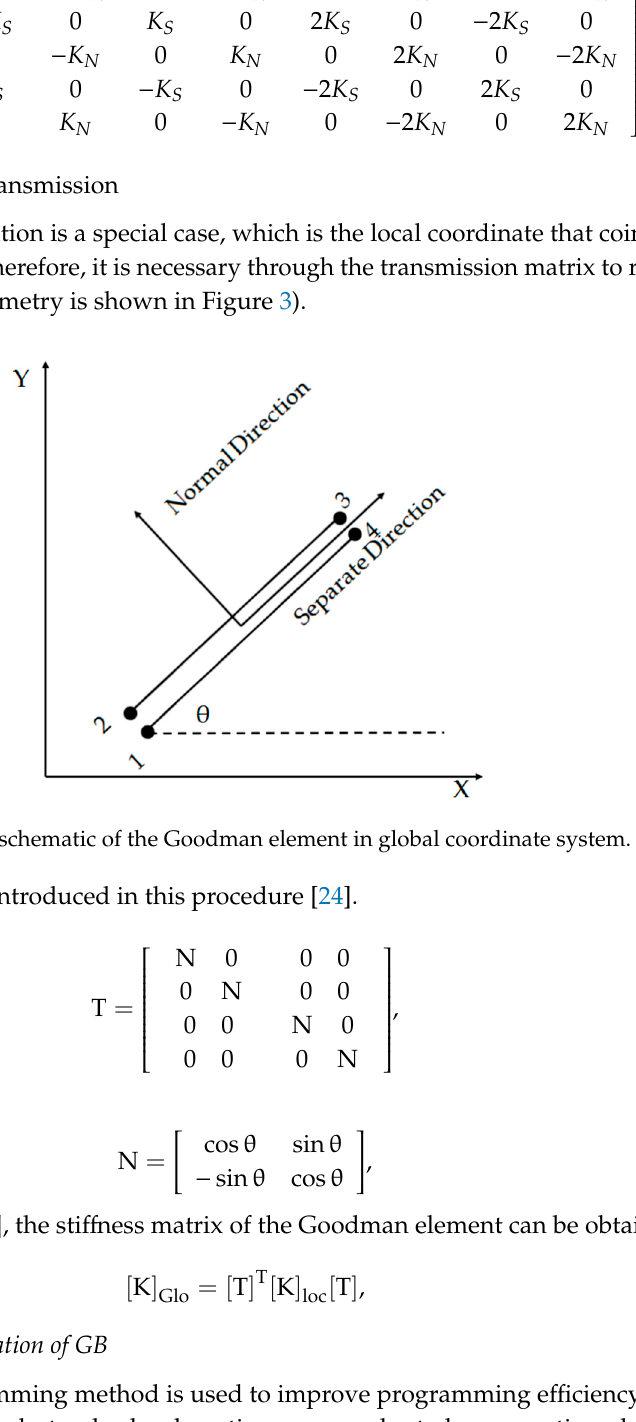
Table 2. Developed subroutines for GB simulation.